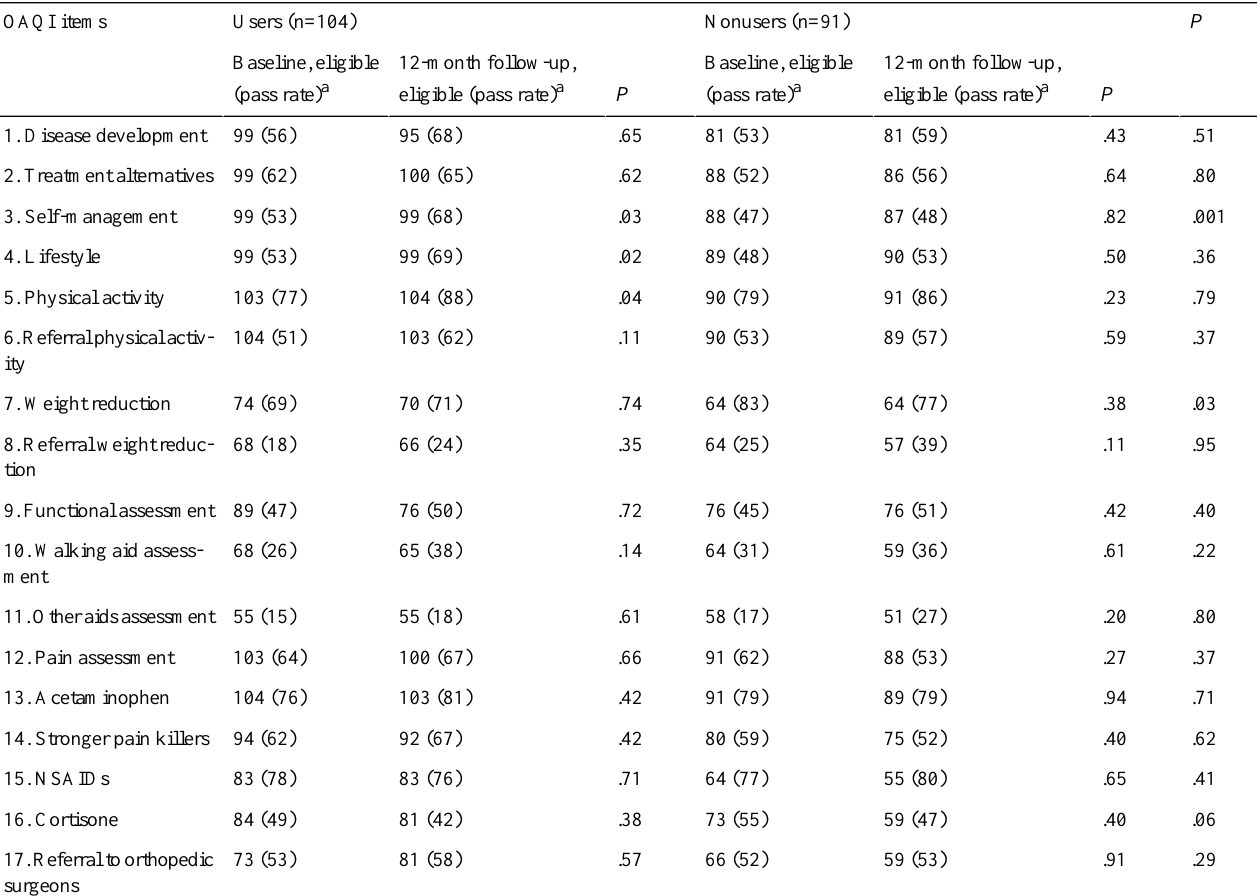
Table 3. Outcomes of the Osteoarthritis Quality Indicator at baseline and 12 months for users and nonusers of the My Joint Pain